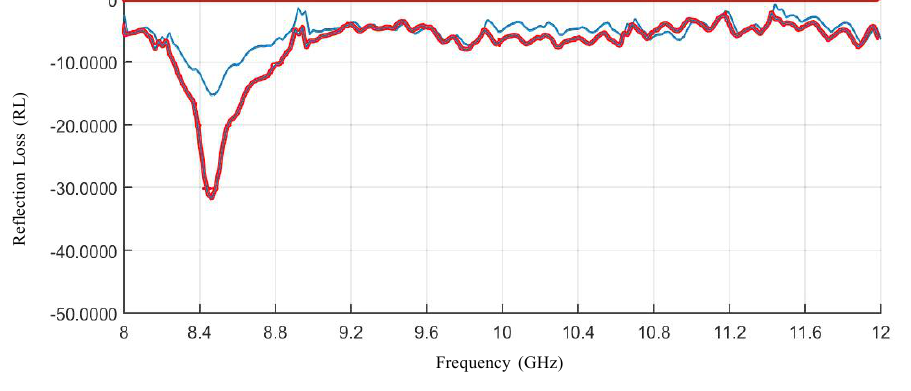
Fig. 8. The RL curve of A7 (blue) and A8 (red) samples.